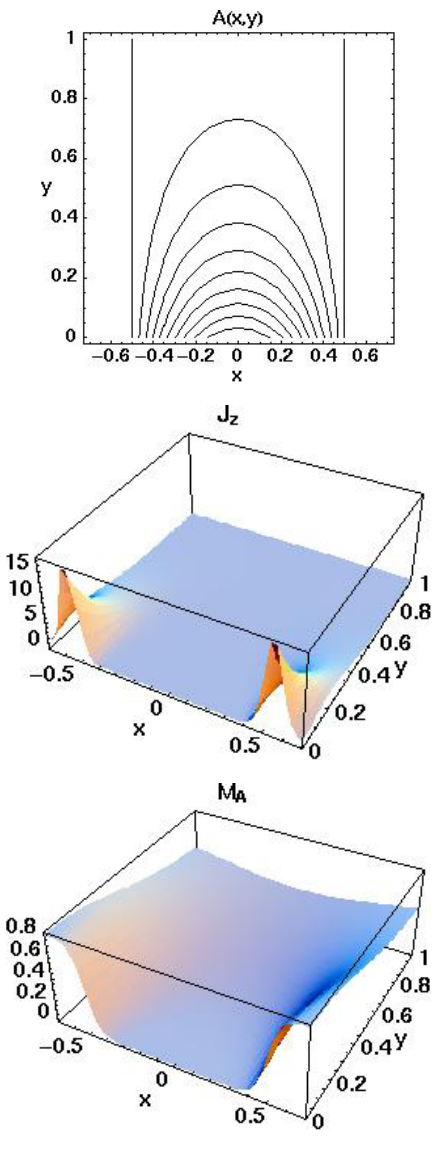
Fig. 2. 2-D potential field configurations in the form A(x,y) = p B 0 exp ( − kπy/L) cos ( − k 2 − c 2 πx/L) , with B 0 = k = L = 1, c = 0 . 0 and the Alfv´en Mach number profile function (29) with d = 5, M 1 = 0 . 4, M 2 = 0 . 0, A c = 0. This profile has a steep gradient at the boundary between open and closed field lines. Top panel: magnetic field lines (contour lines of A(x,y) ), center: formation of flow driven current sheets J z (x,y) , Bottom: Alfv´en Mach number M A (x,y)